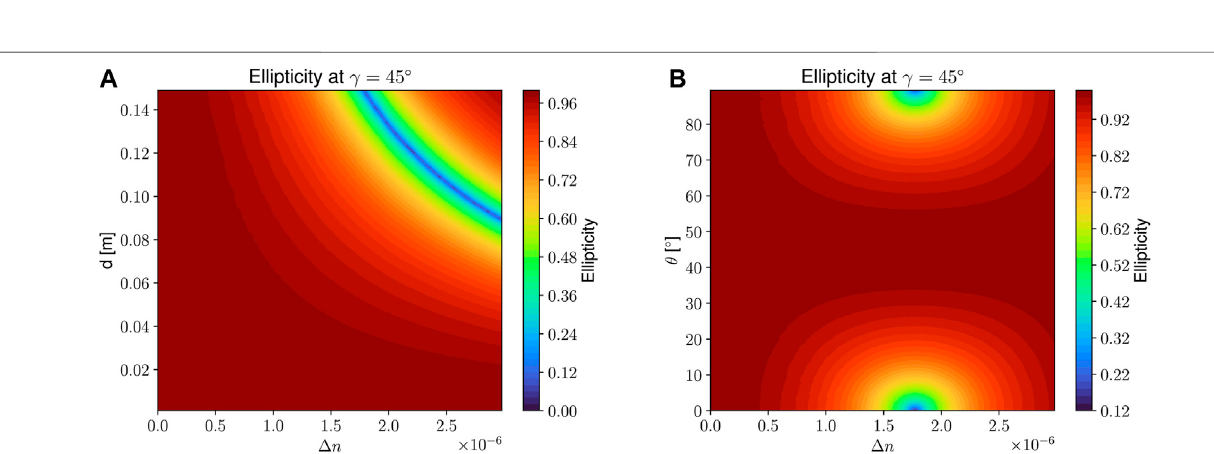
Frontiers in Astronomy and Space Sciences |